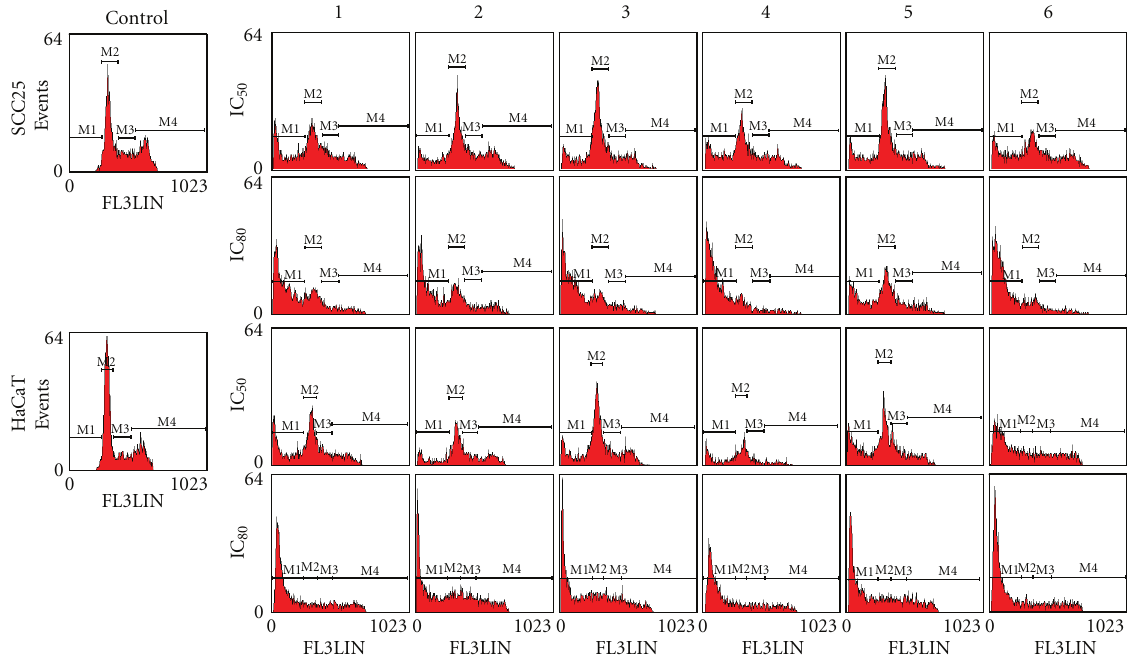
Figure 3: E ff ect of the genus Sinularia extracts on SCC25 and HaCaT cells apoptosis. Flow cytometric analysis of the cell cycle distribution of cells after treatment with extracts (IC 50 and IC 80 ) for 18 hours as described in Materials and Methods. S . grandilobata , 1; S . parva , 2; S . triangula , 3; S . scabra , 4; S . nanolobata , 5 and S . gibberosa ,